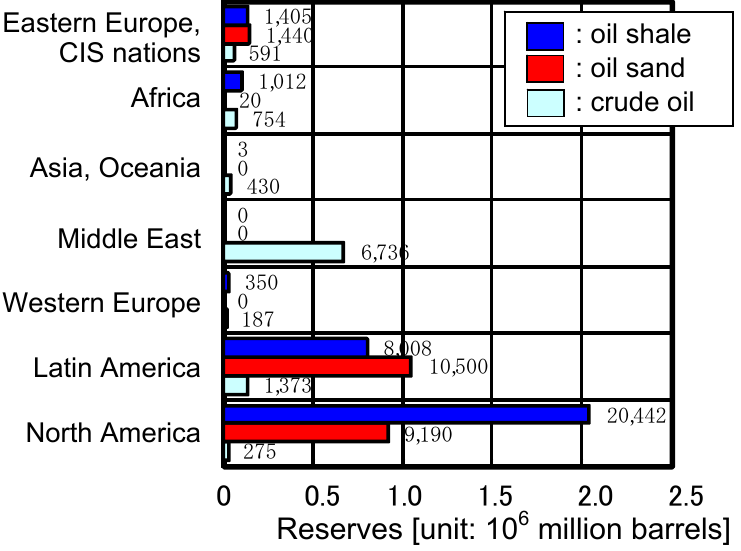
Figure 1. Discoverable reserves of crude oil, oil sand and oil shale [1]. Numerical value in each bar graph is expressed by the unit of hundred million